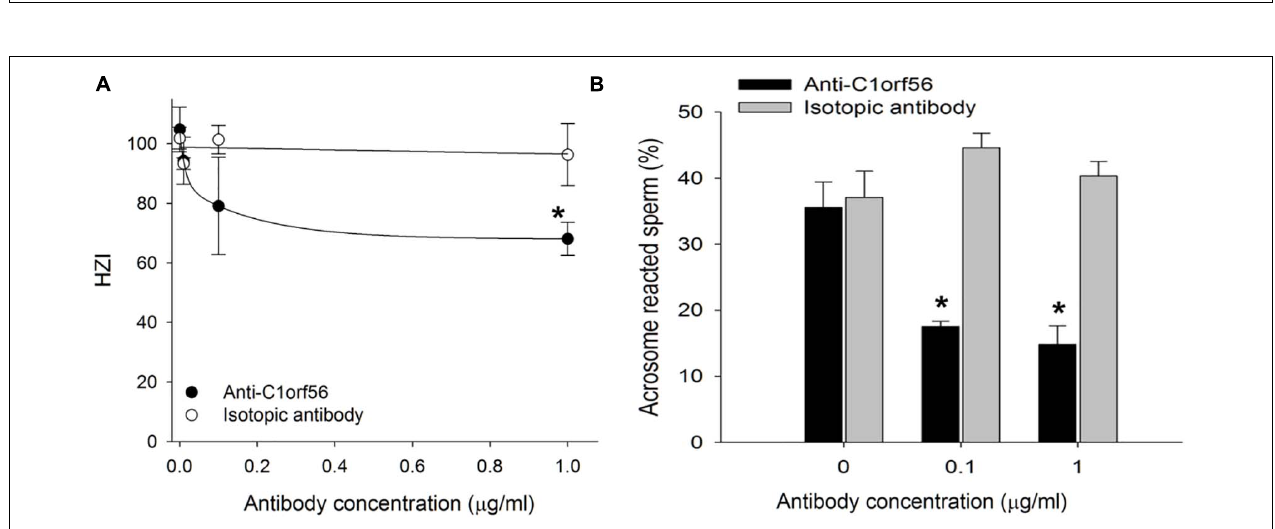
FIGURE 4 | Anti-C1orf56 antibody inhibits spermatozoa-ZP interaction. Capacitated spermatozoa were incubated in culture medium supplemented with different concentrations of anti-C1orf56 antibody. The (A) ZP-binding capacity and (B) solubilized ZP-induced acrosome reaction of the sperm were then determined by hemizona assay and FITC-PSA staining, respectively. Hemizona binding index (HZI) was the ratio of the number of bound spermatozoa on the test hemizona to that on the control hemizona times 100. * P < 0.05 when compared with the corresponding control with isotypic matched antibody.